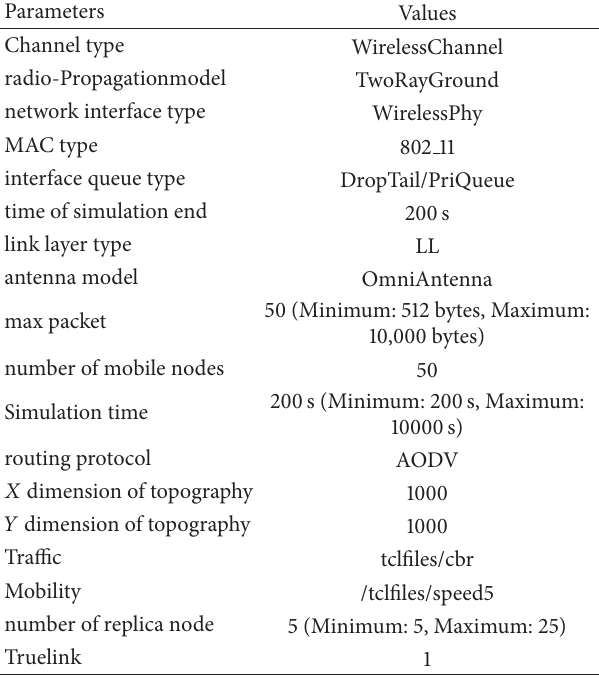
Table 2: Simulation